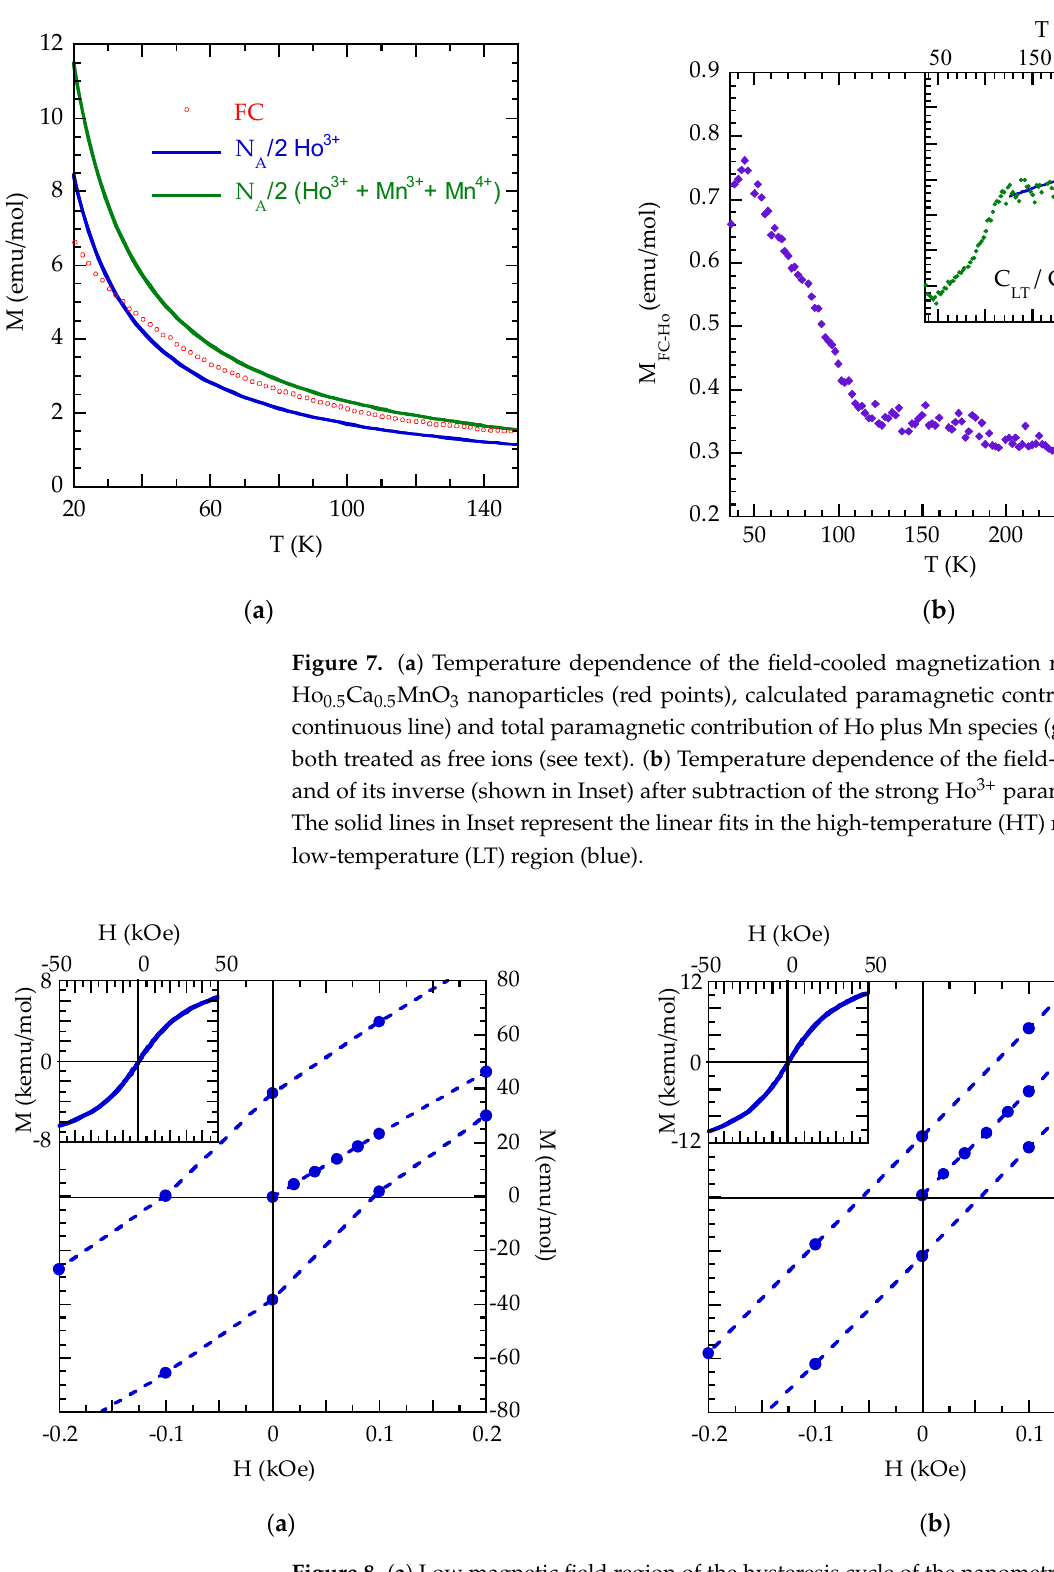
Figure 8. ( a ) Low magnetic field region of the hysteresis cycle of the nanometric sample measured at 5 K. ( b ) Low magnetic field region of the hysteresis cycle of the micrometric sample measured at 5 K. Insets show the complete hysteresis loops for the two samples.